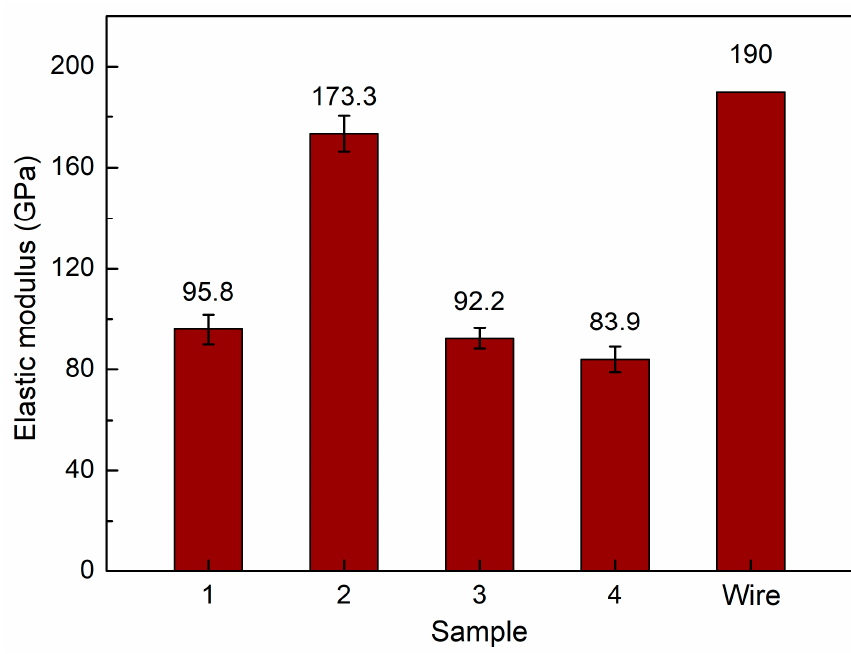
Figure 7. Average elastic modulus of samples at di ff erent WAAM strategies. After the tensile test, the fracture surface of the WAAM sample is observed via SEM microstructure. The SEM fracture surfaces of samples at di ff erent WAAM strategies are displayed in Figure 8. The failure in Figure 8 is observed in the fracture surface of the tensile test. In contrast, the tensile test piece is machined from the printing block, and therefore, the failure occurs at the center of the weld bead. The dimple shapes appear on the fracture surface of all samples, indicating the ductile characteristic of the WAAM sam- ples [47]. These fracture surfaces’ equiaxial shape also represents the original microstruc- ture’s equiaxial shape, as shown in Figure 2.